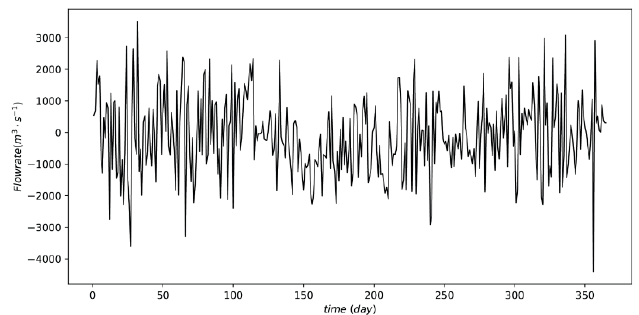
Figure 13. Calculated water flow discharge through the Strait of Baltiysk in 2008.